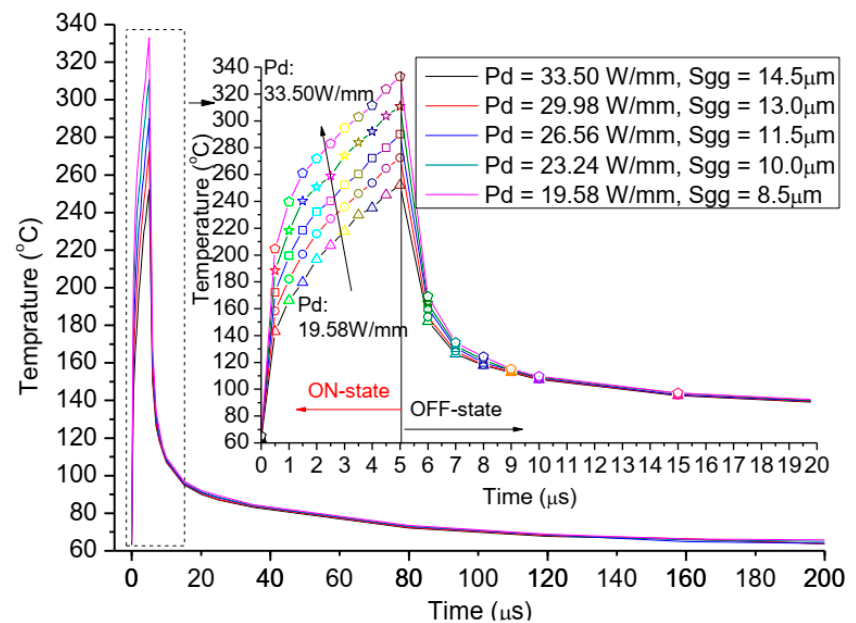
Figure 7. The relationships between transient channel temperature and the changes of power density and gate pitch spacing.